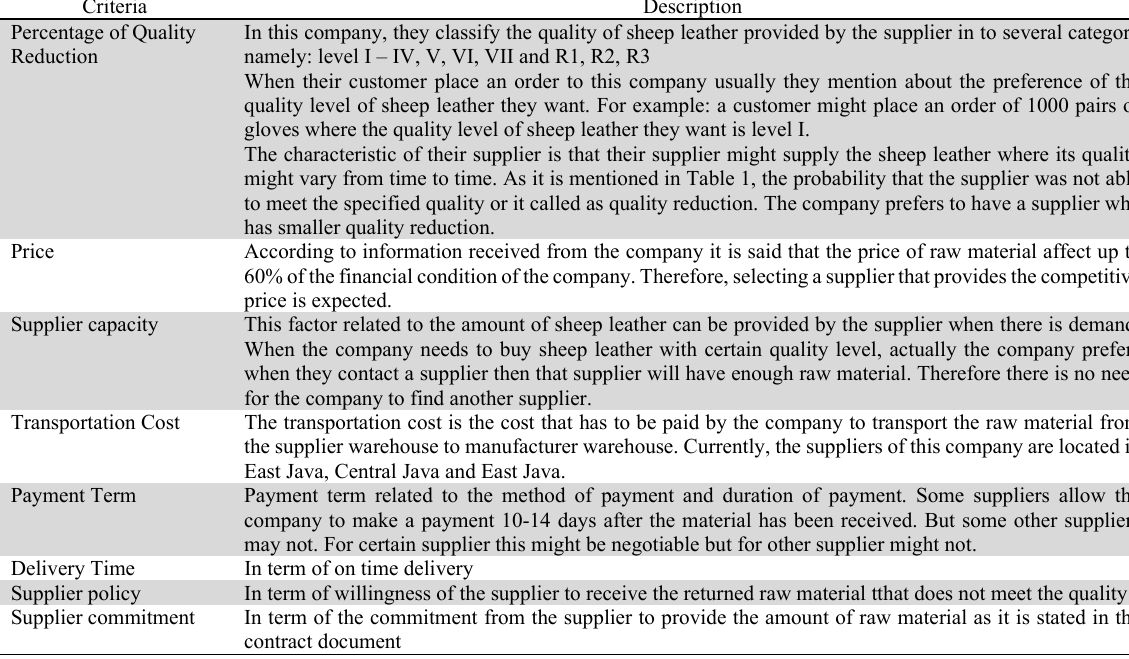
Factors considered by the company to select their suppliers Criteria Description Percentage of Quality